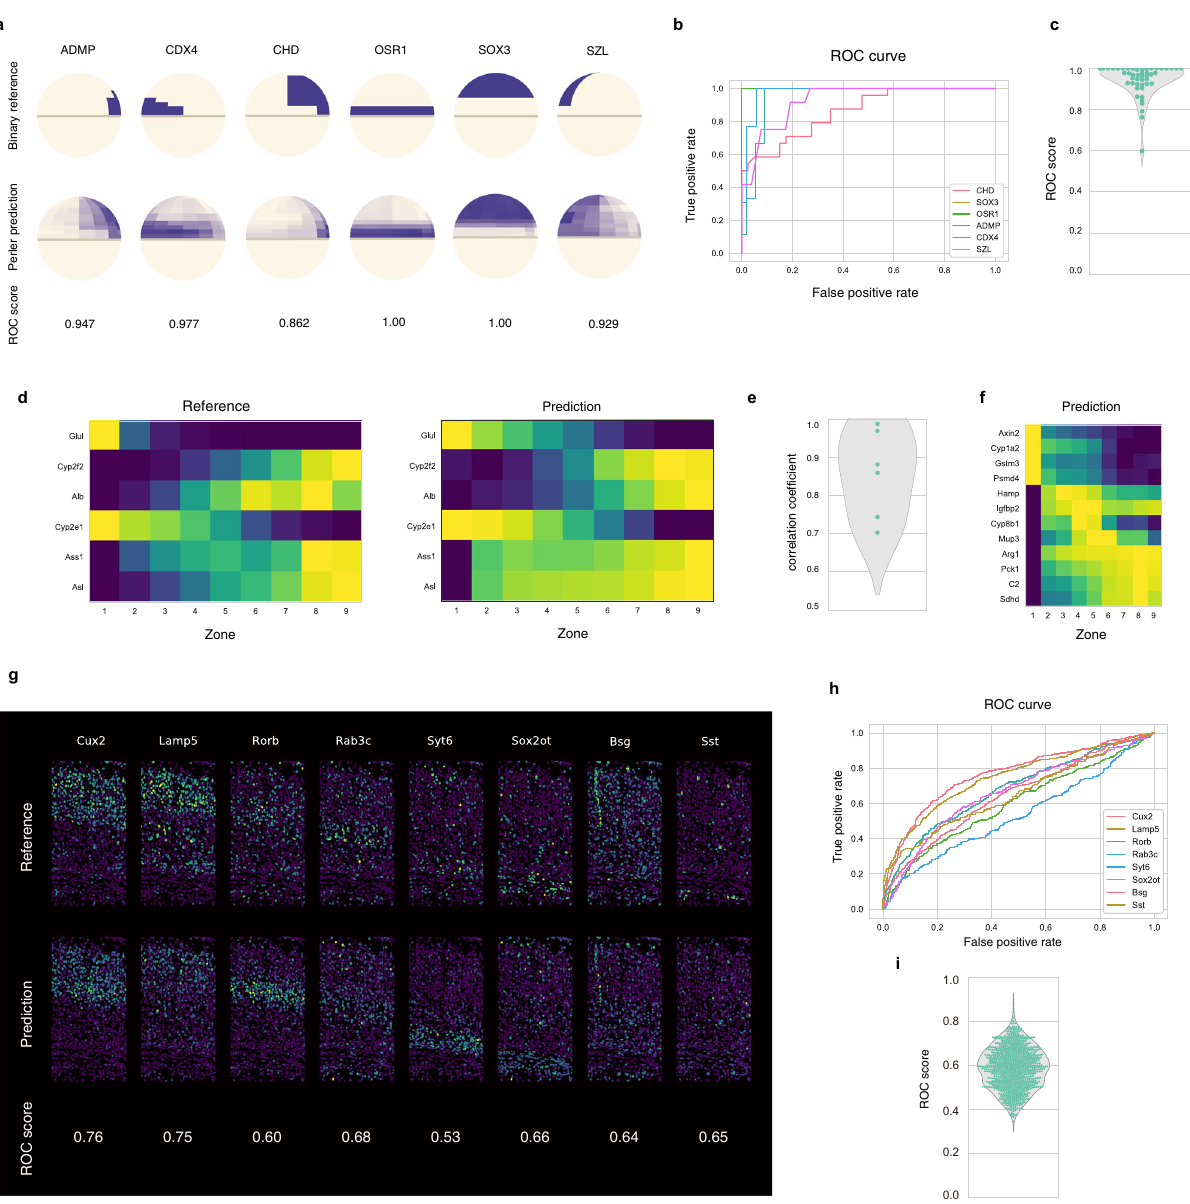
Fig. 6 Applications of Perler to other data. a – c Application of Perler for early zebra fi sh embryo data. a LOOCV experiments. The upper and lower panels show the referenced ISH data and predicted gene-expression pro fi les, respectively. b ROC curve for the LOOCV experiments for the genes shown in a . c Violin plot for the predictive accuracies of Perler for the LOOCV experiments for all genes in the reference ISH data according to ROC score. d – f Application of Perler for mammalian liver lobules. d LOOCV experiments. The left and right panels show the reference ISH data and predicted gene- expression pro fi les, respectively. All genes from the ISH data are shown. e Violin plot for the predictive accuracies of Perler for the LOOCV experiments for all genes in the reference ISH data. f Prediction of non-landmark genes. In addition to the monotonic gene-expression pro fi les, non-monotonic gene- expression pro fi les are observed (Hamp, Igfbp2, Cyp8b1, and Mup3) 7 . g , h Application of Perler for the mouse visual cortex. g Cross-validation (CV) study (tenfold). The upper and lower panels show the referenced ISH data and predicted gene-expression pro fi les, respectively. h ROC curve for the CV experiments of genes shown in g . i Violin plot representing the predictive accuracies of Perler for the tenfold CV experiments of all genes in the reference ISH dataset according to ROC score. The median ROC score is 0.59. Source data are provided in a Source data fi